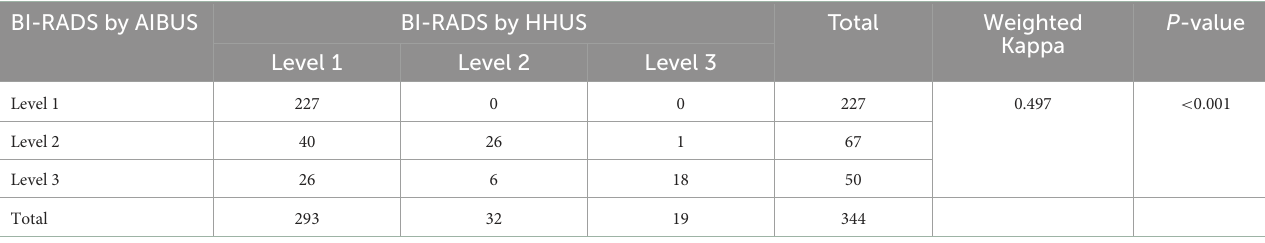
TABLE 3 Comparison between AIBUS read by senior radiologists and HHUS in BI-RADS categorization. BI-RADS by AIBUS